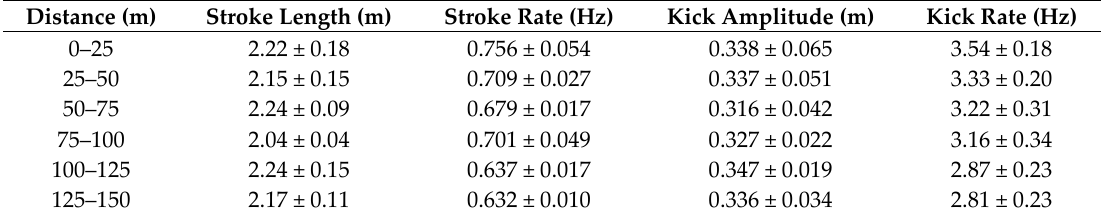
Table 2. Swimming kinematics data throughout the 200-m front crawl (n =